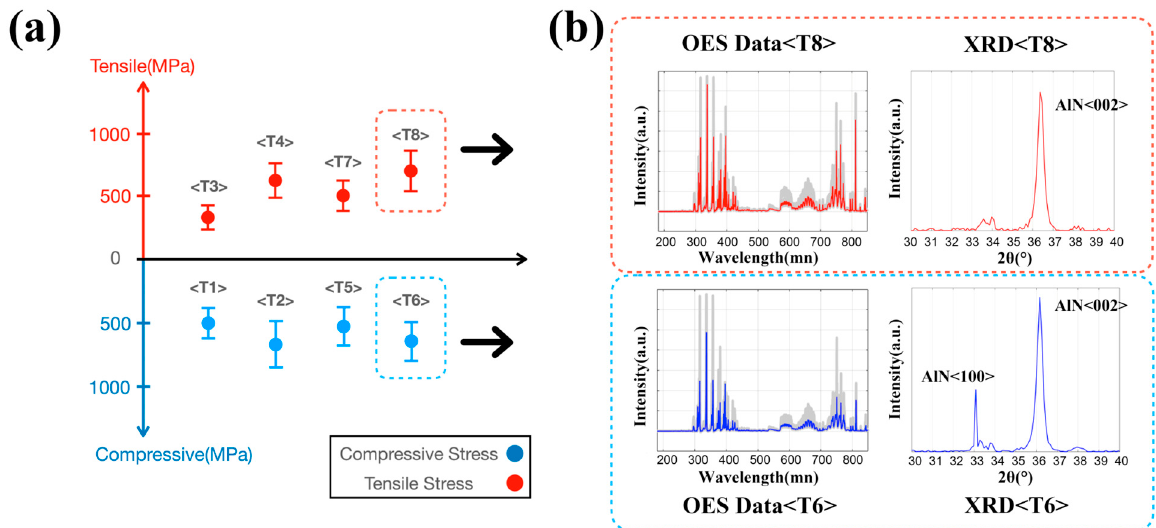
Figure 6. ( a ) Scatter plot with error bars calculated from XRD result reflecting eight groups (Table 1) of the experiment for MLP model training; ( b ) OES data plot (colored line: mean value of data, shadowed space: complete data) and XRD plot from 30 to 40 degree in 2 θ diffraction angle of specific groups (T6 and T8).